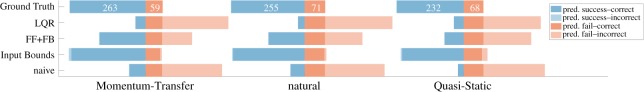
This figure compares the predictive accuracy of the SBs formed using the Input Bounds controller to three other methods. Results are presented for each Sit-to-Stand strategy, aggregated across subjects. The Input Bounds controller’s predictions for both successes and failures are near the ground truth, while the three other methods predict many more failures than were experimentally observed.